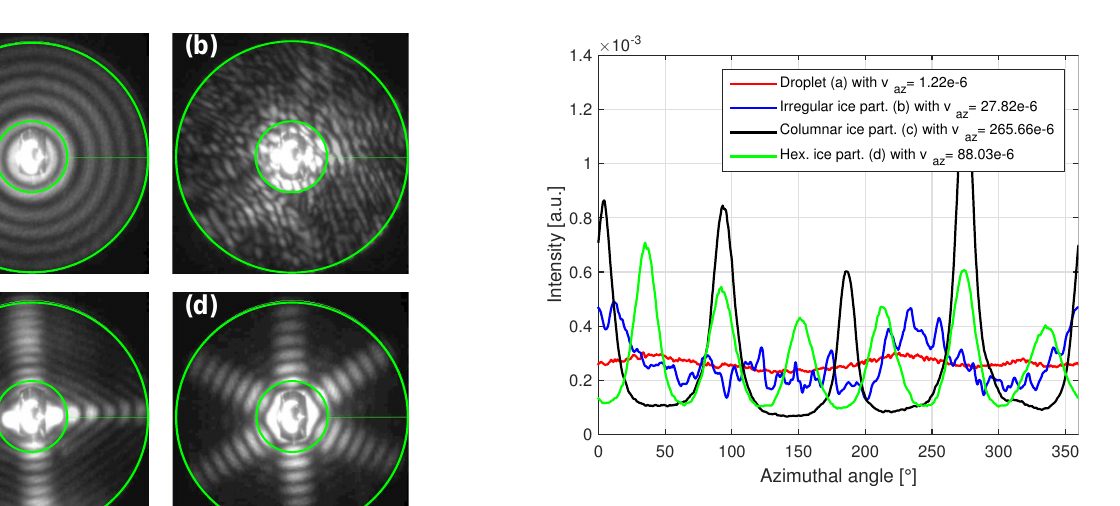
Figure 2. Polar integrated azimuthal intensities of the particles dis- played in Fig.